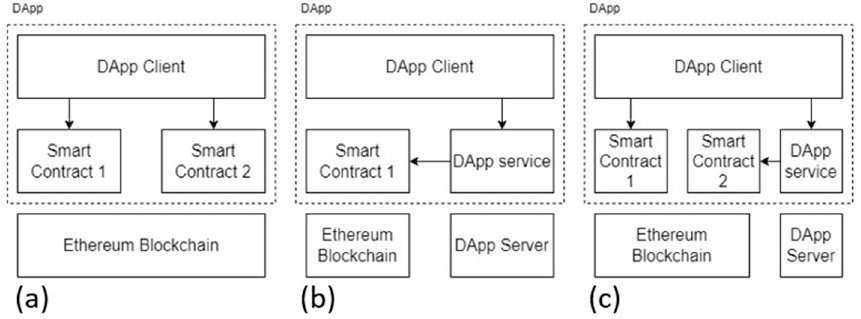
Figure 1. Three different architectures of distributed applications. ( a ) Direct Architecture; ( b ) Indirect Architecture; ( c ) Mixed Architecture.